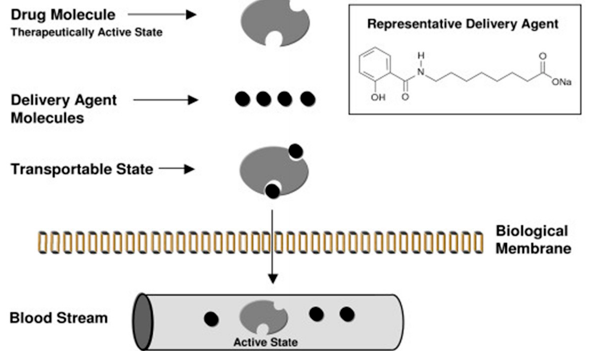
Figure 3. Schematic of Eligen® drug-delivery technology mechanism in intestinal epithelia,